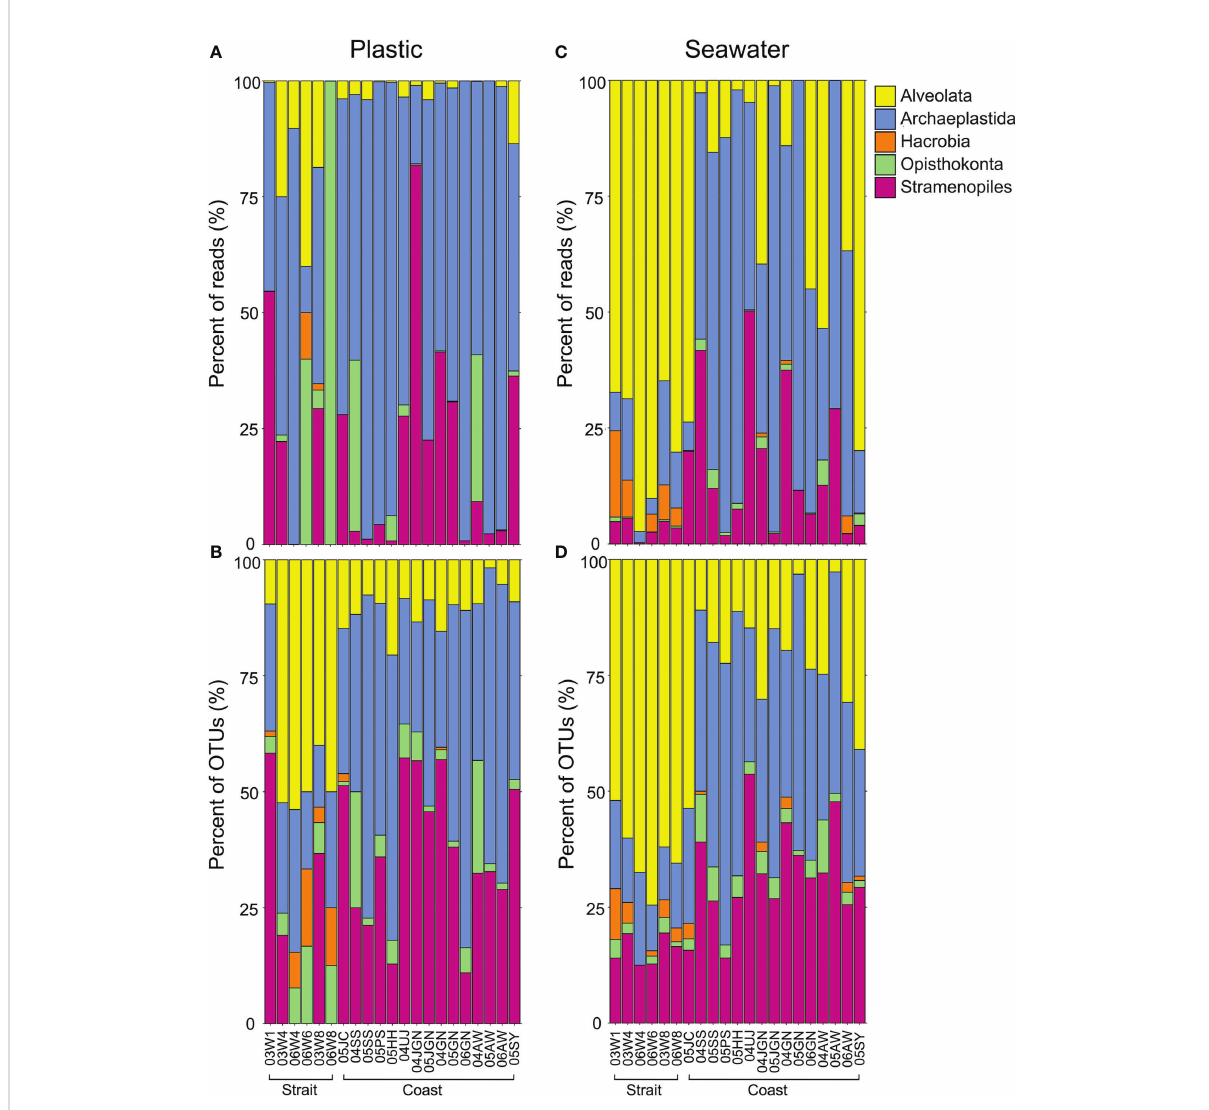
FIGURE 6 Bar graphs illustrating the relative proportion of the number of reads and the number of operational taxonomic units (OTUs) in the taxonomic supergroups detected in plastic and seawater samples. (A, B) , plastic samples; (C, D) , seawater